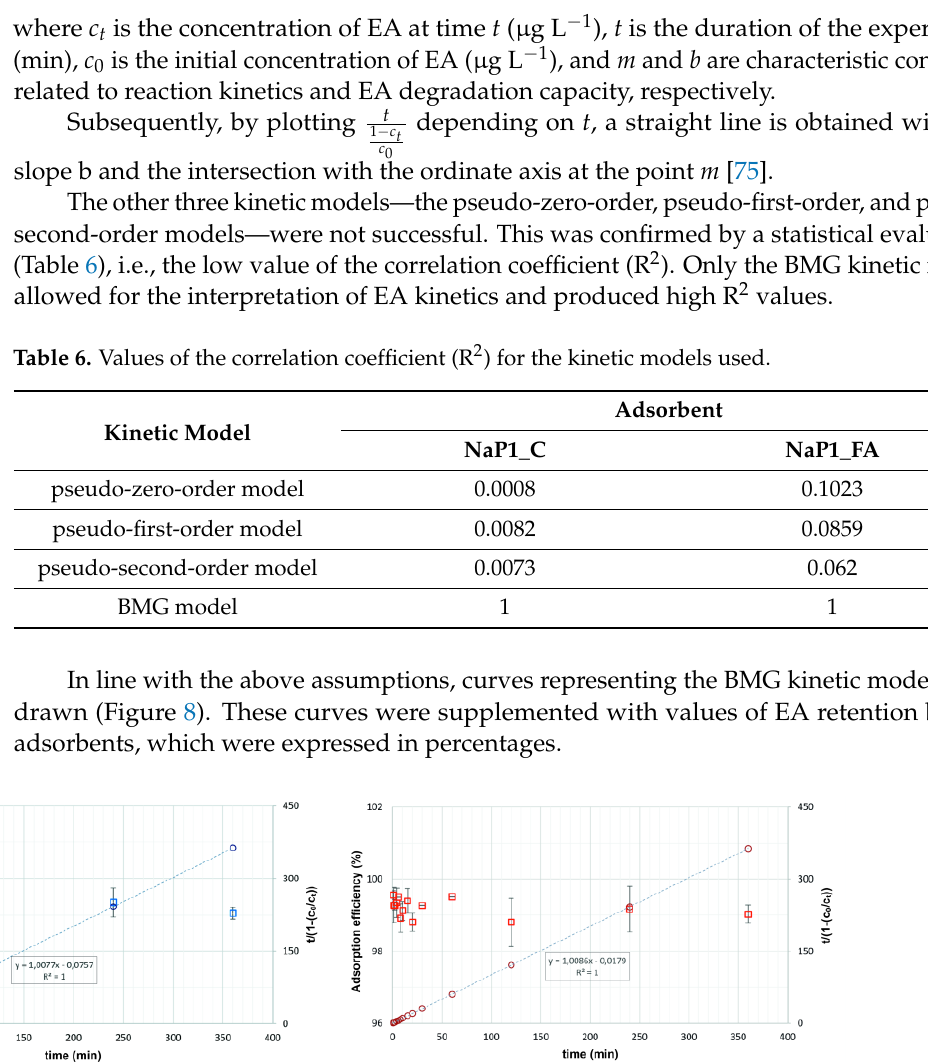
Figure 8. BMG kinetic models for the adsorption of EA on ( a ) NaP1_C and ( b )